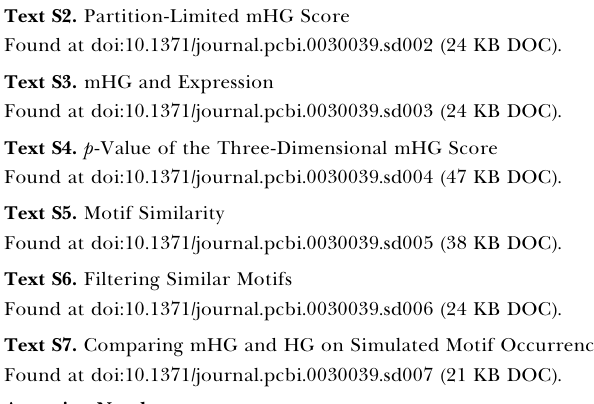
Table S1. List of TFs in the Harbison Filtered Dataset Table S2. Motif Predictions of DRIM on the Harbison Filtered Dataset Table S3. Comparison between the Predictions of DRIM and Those Reported in [25] Table S4. Comparison between mHG Flexible Cutoffs and 10 (cid:2) 3 Fixed Cutoffs in Yeast ChIP–chip Data The National Center for Biotechnology Information (NCBI) (http:// www.ncbi.nlm.nih.gov) accession numbers for the genes discussed